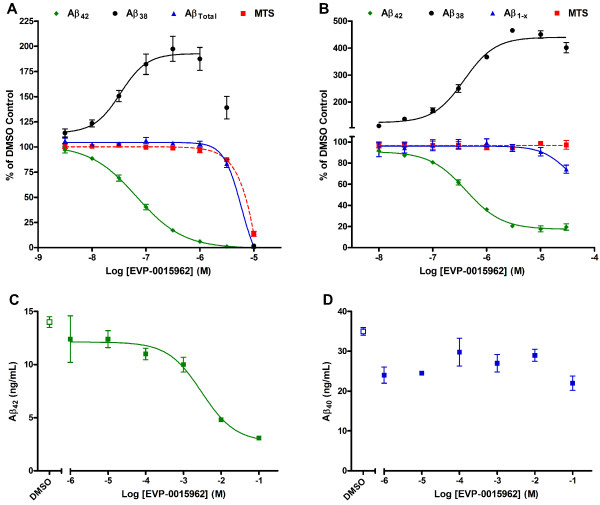
EVP-0015962 is a potent γ-secretase modulator. A. Concentration response curves for Aβ42, Aβ38, and AβTotal determined by enzyme-linked immunosorbent assay (ELISA), and for cell viability in the H4-APP751 cell assay. IC50 = 67 nM for Aβ42 and EC50 = 33 nM for Aβ38. For cell viability determined using the MTS assay, IC50 = 5.56 μM. IC50 > 3 μM for AβTotal. For Aβ38, the EC50 value is determined for the concentration range of 3 nM to 1 μM of EVP-0015962, to avoid the portion of the curve where toxicity is observed. N = 6 independent experiments. B. Concentration response curves for Aβ42, Aβ38, and Aβ1-x determined by ELISA in media and for MTS from rat primary neocortical cultures. IC50 = 427 nM for Aβ42 and EC50 = 384 nM for Aβ38. IC50 > 30 μM for Aβ1-x and the MTS assay. N = 4 independent experiments for Aβ42, Aβ1-x, and MTS and 2 for Aβ38. C. Concentration response curve for Aβ42 in the cell-free assay. IC50 = 3.9 μM. D. Concentration response curve for Aβ40 in the cell-free assay. In the cell-free assays, Aβ was determined by AlphaLisa in triplicate. All data are expressed as mean ± standard error of the mean (SEM). For some data points, error bars are smaller than the sizes of the data points.